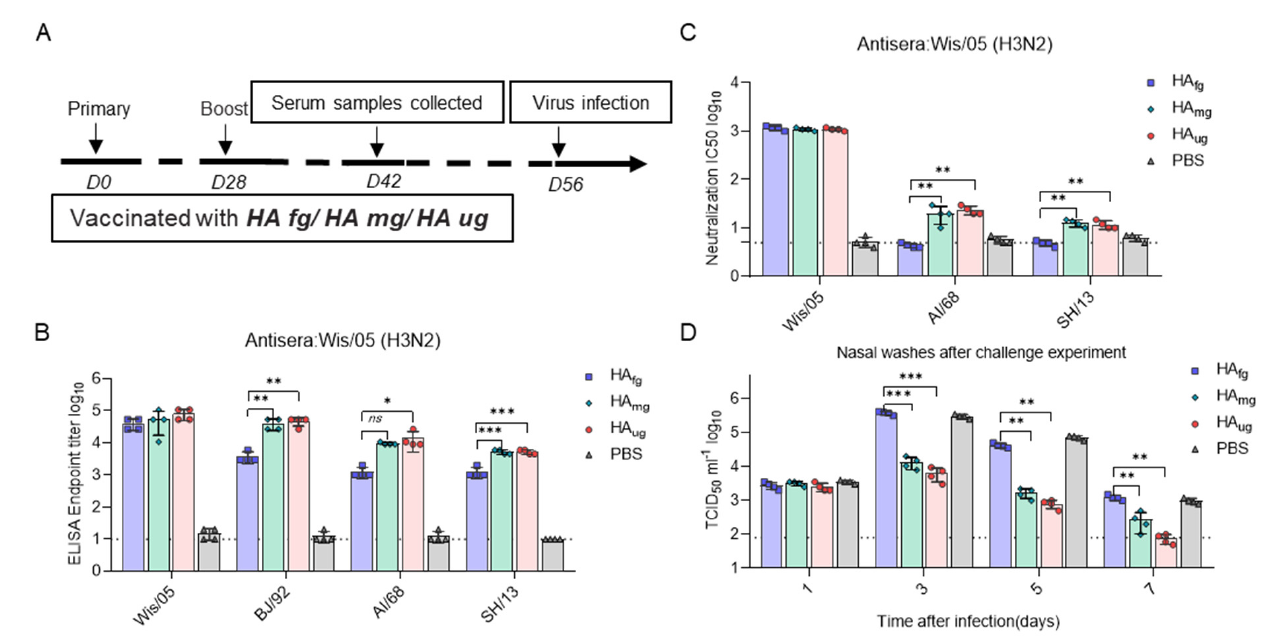
Figure 4. Glycosidase-treated HA vaccines induce protective immunity against influenza virus infection in ferrets. ( A ) Timeline of vaccination and challenge experiments in ferrets. Ferrets (4 ferrets in each group) were immunized with 30 μ g of HA fg , HA mg and HA ug on day 0 and 28. Sera were collected and measured at 14 days after boost immunization. ( B ) ELISA endpoint titers were determined for Wis/05 (H3N2), AI/68 (H3N2) and SH/13 (H7N9). The immunized ferrets were challenged on day 58 with BJ/92(H3N2). The nasal washes were collected every other day for 7 days beginning at 1 dpi for viral load titration. ( C ) Serum neutralizing antibody titers were determined for Wis/05 (H3N2), Vic/11 (H3N2), BJ/92 (H3N2), AI/68 (H3N2), and SH/13 (H7N9). ( D ) Virus titers were determined by TCID50 assay at 1 dpi, 3 dpi, 5 dpi and 7 dpi post challenge in the nasal washes (NTs) of ferrets. Data are presented as the mean ± SEM. The results were calculated with Prism software using Student’s t test; significant differences are marked as * p < 0.05; ** p < 0.01; *** p < 0.001.